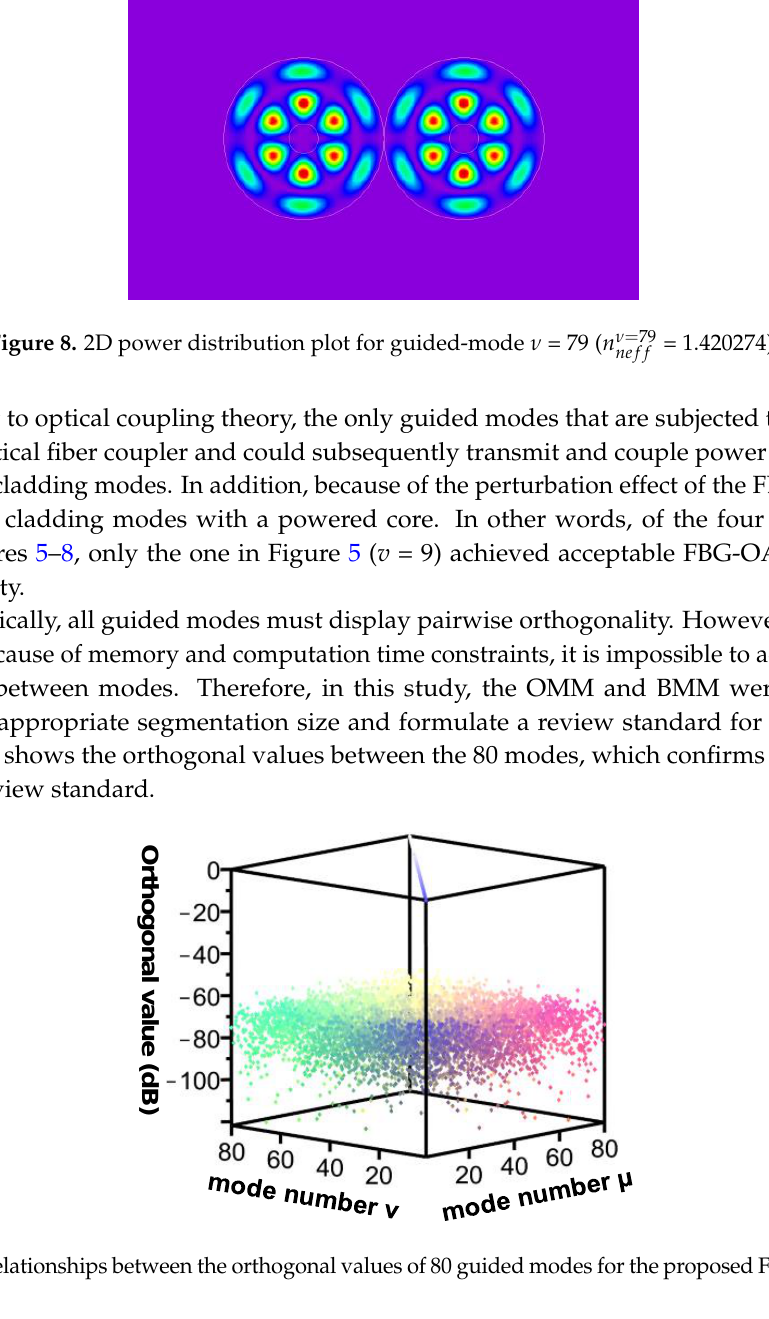
Figure 9. Relationships between the orthogonal values of 80 guided modes for the proposed FBG-OADM.